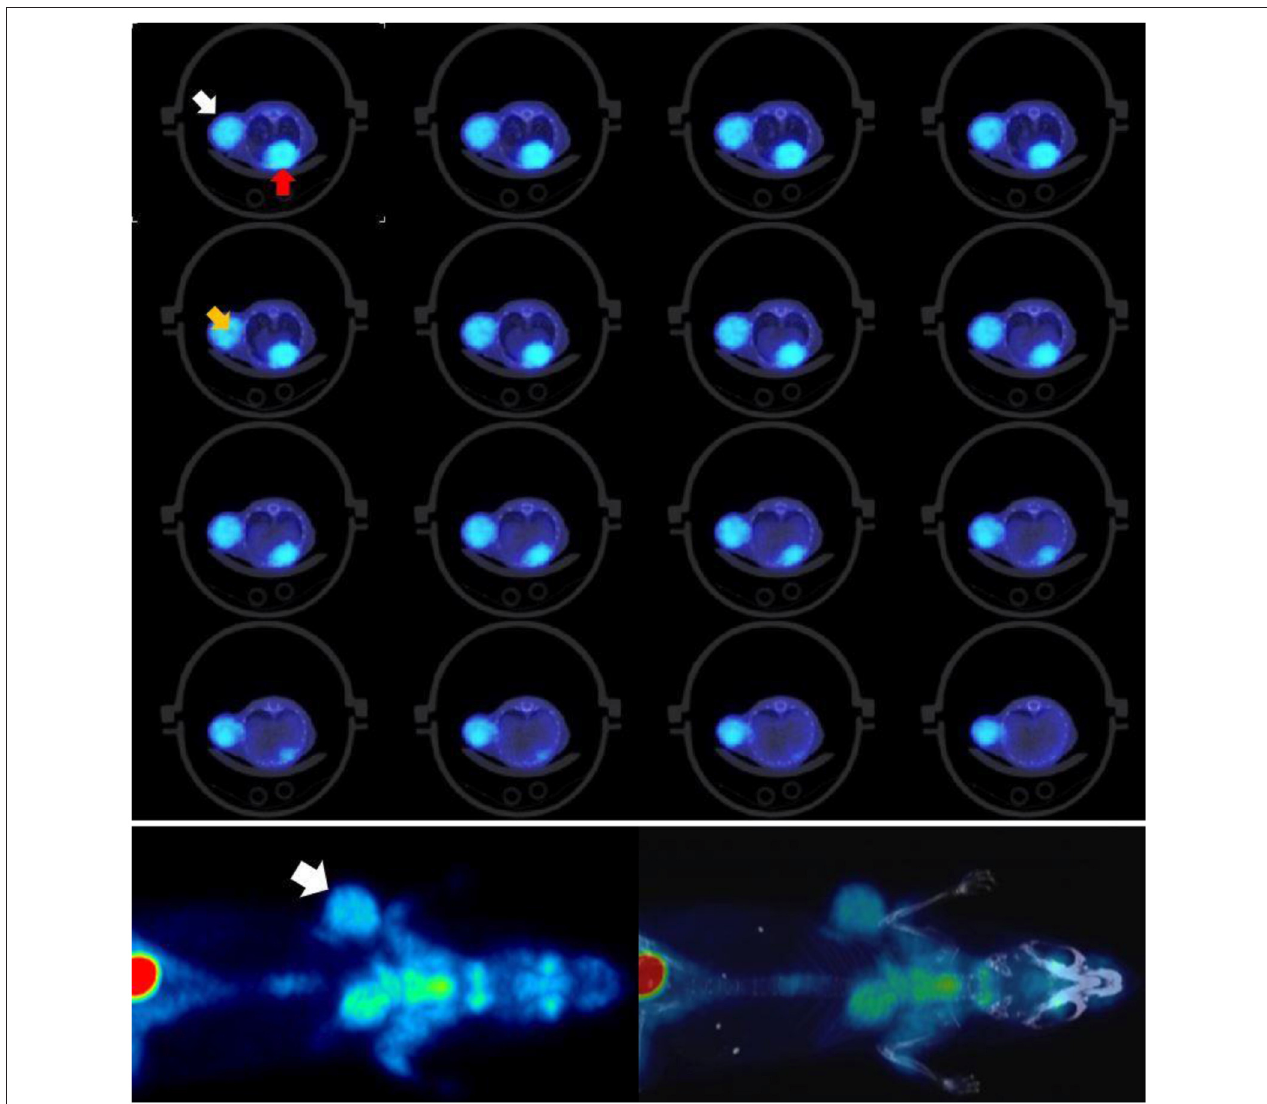
FIGURE 7 | Mouse 1 of fibrosarcoma tumor model. Top: Tumor is marked by white arrow and heart by red arrow. Contrast and resolution are sufficient to resolve heterogenous tumor uptake, see orange arrow. Bottom: Low-dose total-body [ 18 F]FDG/PET with clearly defined tumor uptake and contrast. Tumor uptake measurements (13% ID/mL) obtained fall within typical ranges for this model. Results for 10-minute and 60-minute scans are consistent, indicating that low-dose imaging even for 10 minutes provides sufficient counts for reliable data and